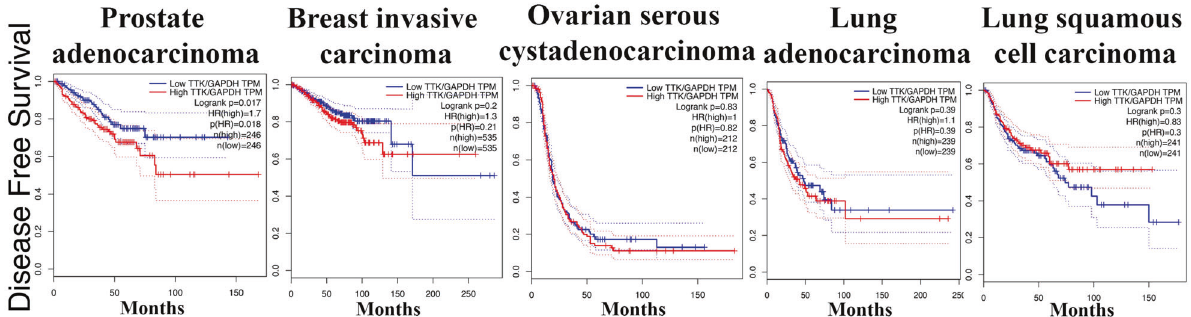
Fig. 6 Disease free survival analysis based on Mps1 expression. Mps1 expression is normalized by GAPDH. Mps1 expression cutoff-High and -Low = 50%. Samples with expression higher or lower than 50% are considered as the high- or low-expression cohort. Logrank p test compares the survival distributions of high and low expression groups. Hazard Rate (HR) is the survival model calculated based on Cox proportional hazards model. HR > 1 indicates reduced survival of patients with high expression of Mps1. High expression of Mps1 is associated with reduced disease-free survival of prostate adenocarcinoma patients. No correlation between levels of Mps1 and patients survival observed in breast, ovarian and lung cancer patients. Data analyzed at: http://gepia.cancer-pku.cn. fi rst (thus activating mitotic block) followed by BAY (presumably forcing mitotic exit) with combined CBZ + BAY treatment in a 3D prostasphere setting. We observed that BAY potentiated cytotoxic activity of CBZ under both treatment conditions (Fig. 2). Drug combination not only reduced size and number of prostaspheres, but also inhibited proliferation within prostaspheres (as indicated by the absence of mitotic cells stained with H3S10P and proliferation marker Ki-67 on spheres sections, Fig. 2e) and abrogated proliferation of cells recovered from prostaspheres (Fig. 2c), indicating the long-term cytotoxic effect of combined treatment.